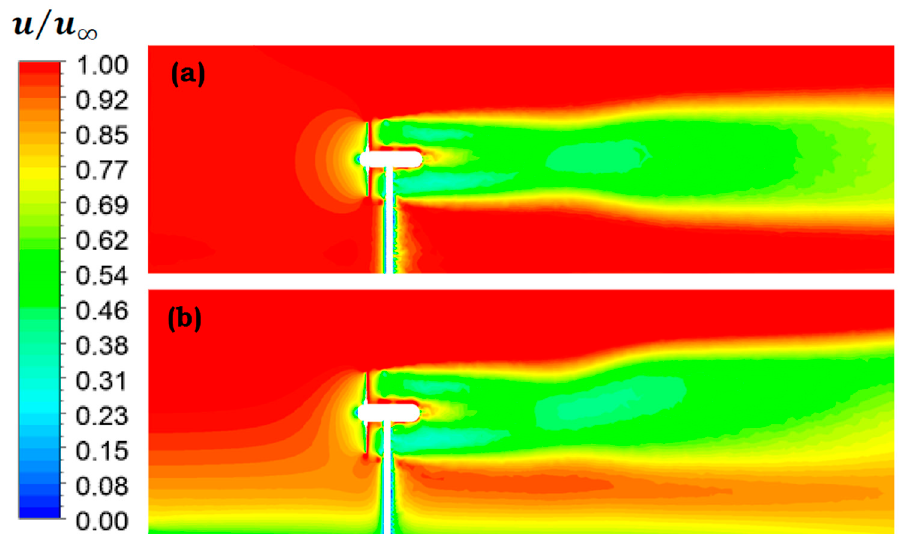
Figure 11. The inflow velocity is una ff ected up to a distance of 2D upstream (x / D = − 2) in both cases. At the turbine location (x / D = 0) and 1D downstream (x / D = 1), the velocity variation is almost similar between the two cases. However, further downstream at (x / D = 3) and beyond that the wake has clearly shifted upwards. For the velocity profile case, the velocity in the upper bypass region of the wake has increased.